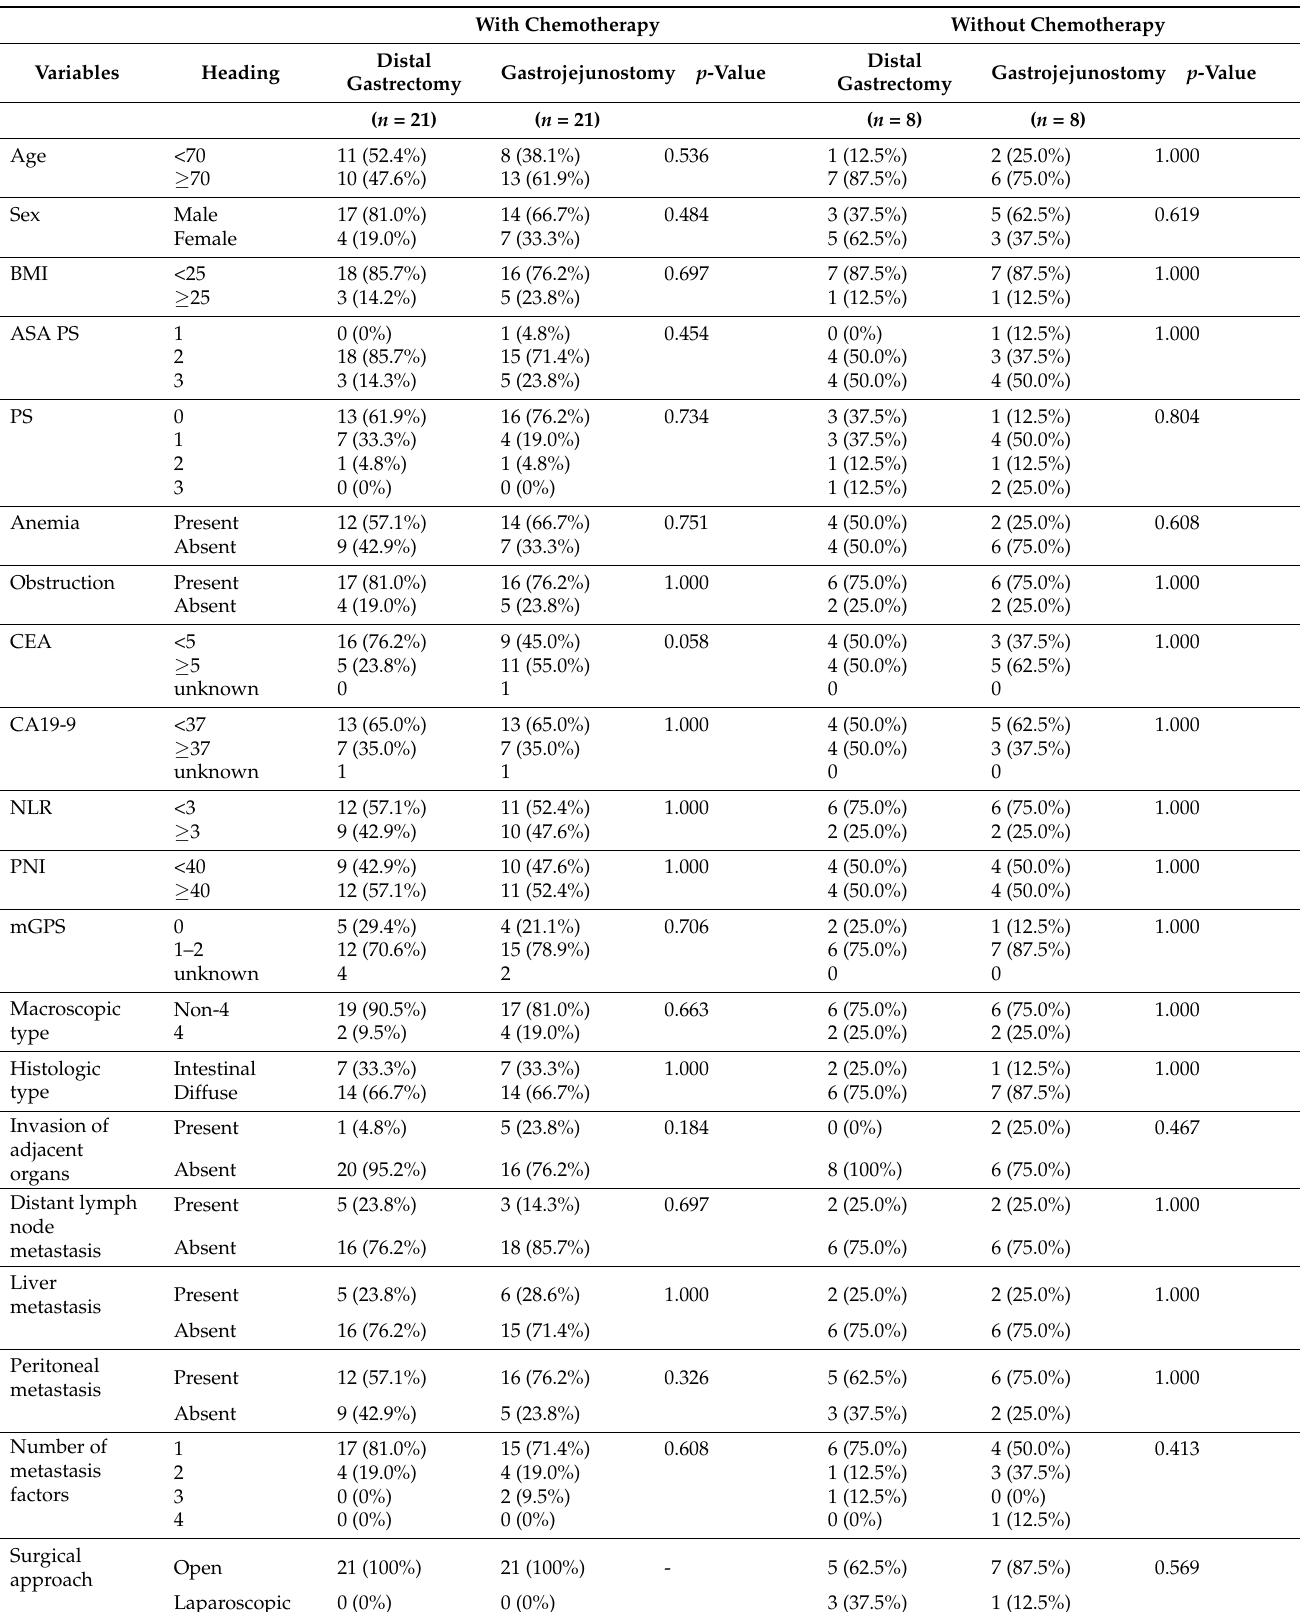
Table 4. General characteristics after propensity score